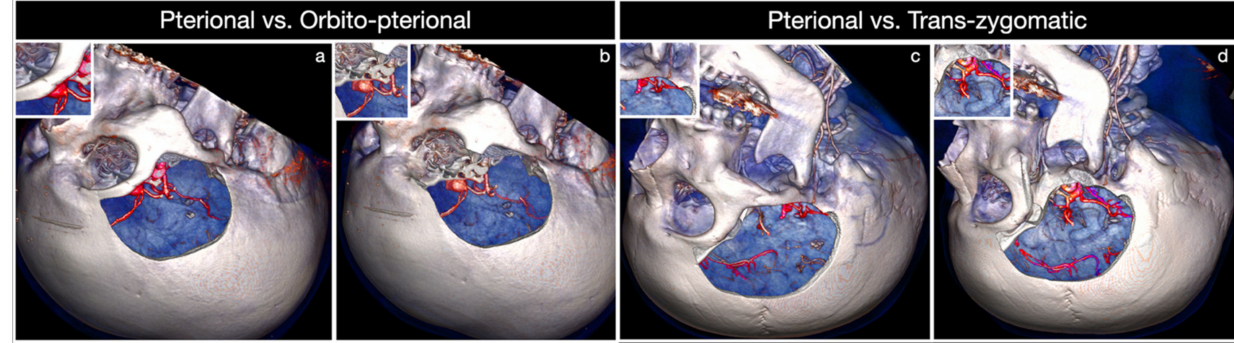
Figure 10. Comparison of the surgical exposure between the pterional ( a ) vs. orbitopterional ( b ) approach and the pterional ( c ) vs. trans-zygomatic ( d )